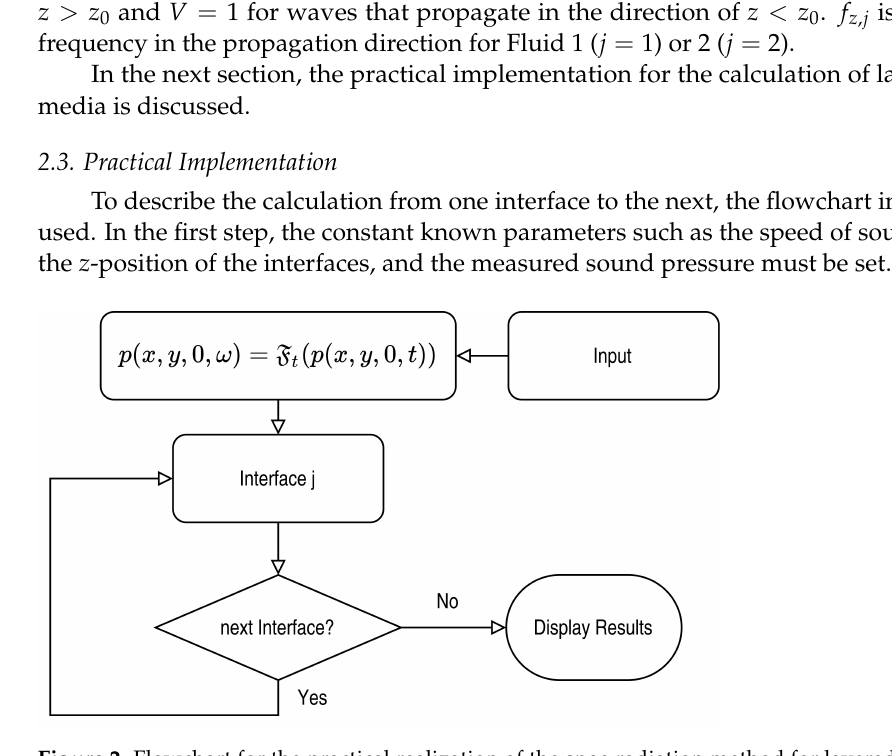
Figure 2. Flowchart for the practical realization of the spec-radiation method for layered fluid